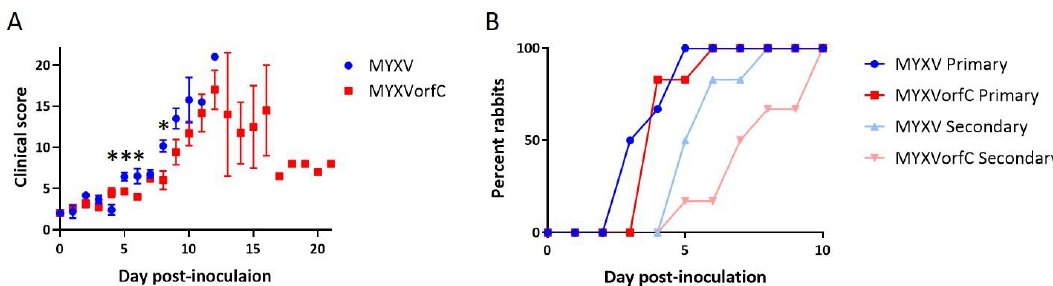
Figure 9. Differences in disease progression in rabbits after intradermal inoculation of 50 pfu MYXV or MYXVorfC ( n = 6 per group). ( A ) Average daily clinical score (error bars = SEM, * p -values < 0.035). ( B ) Day that development of primary and secondary skin lesions was first observed on individual rabbits.